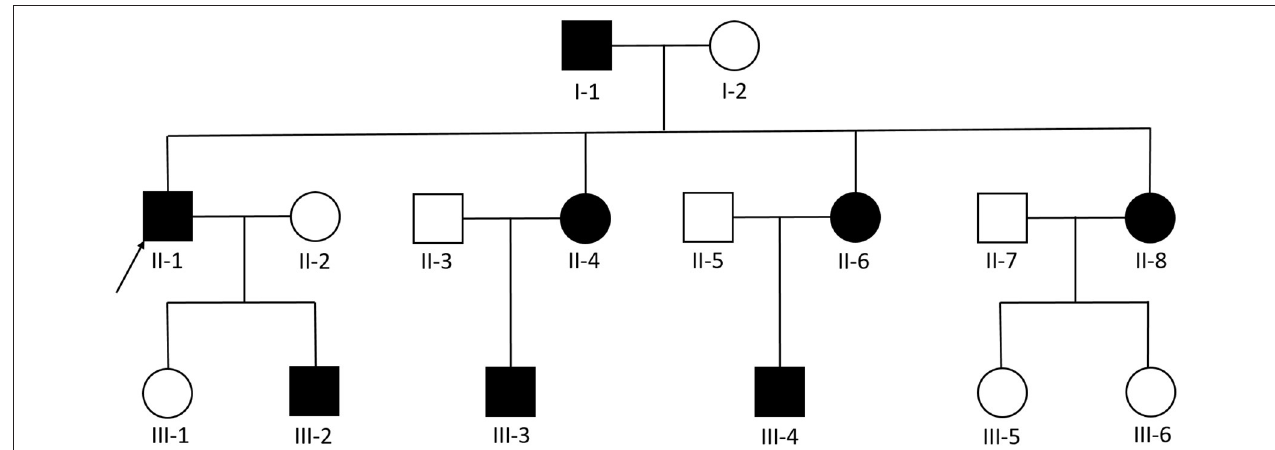
FIGURE 1 | Pedigree diagram of the Chinese family with familial cerebral cavernous malformation, a heterozygous frameshift mutation described as c.1362_1363del (p.Gln455fs) was found in exon 14 of CCM1 . The arrows designate the index patient (proband); filled squire = affected; unfilled square =